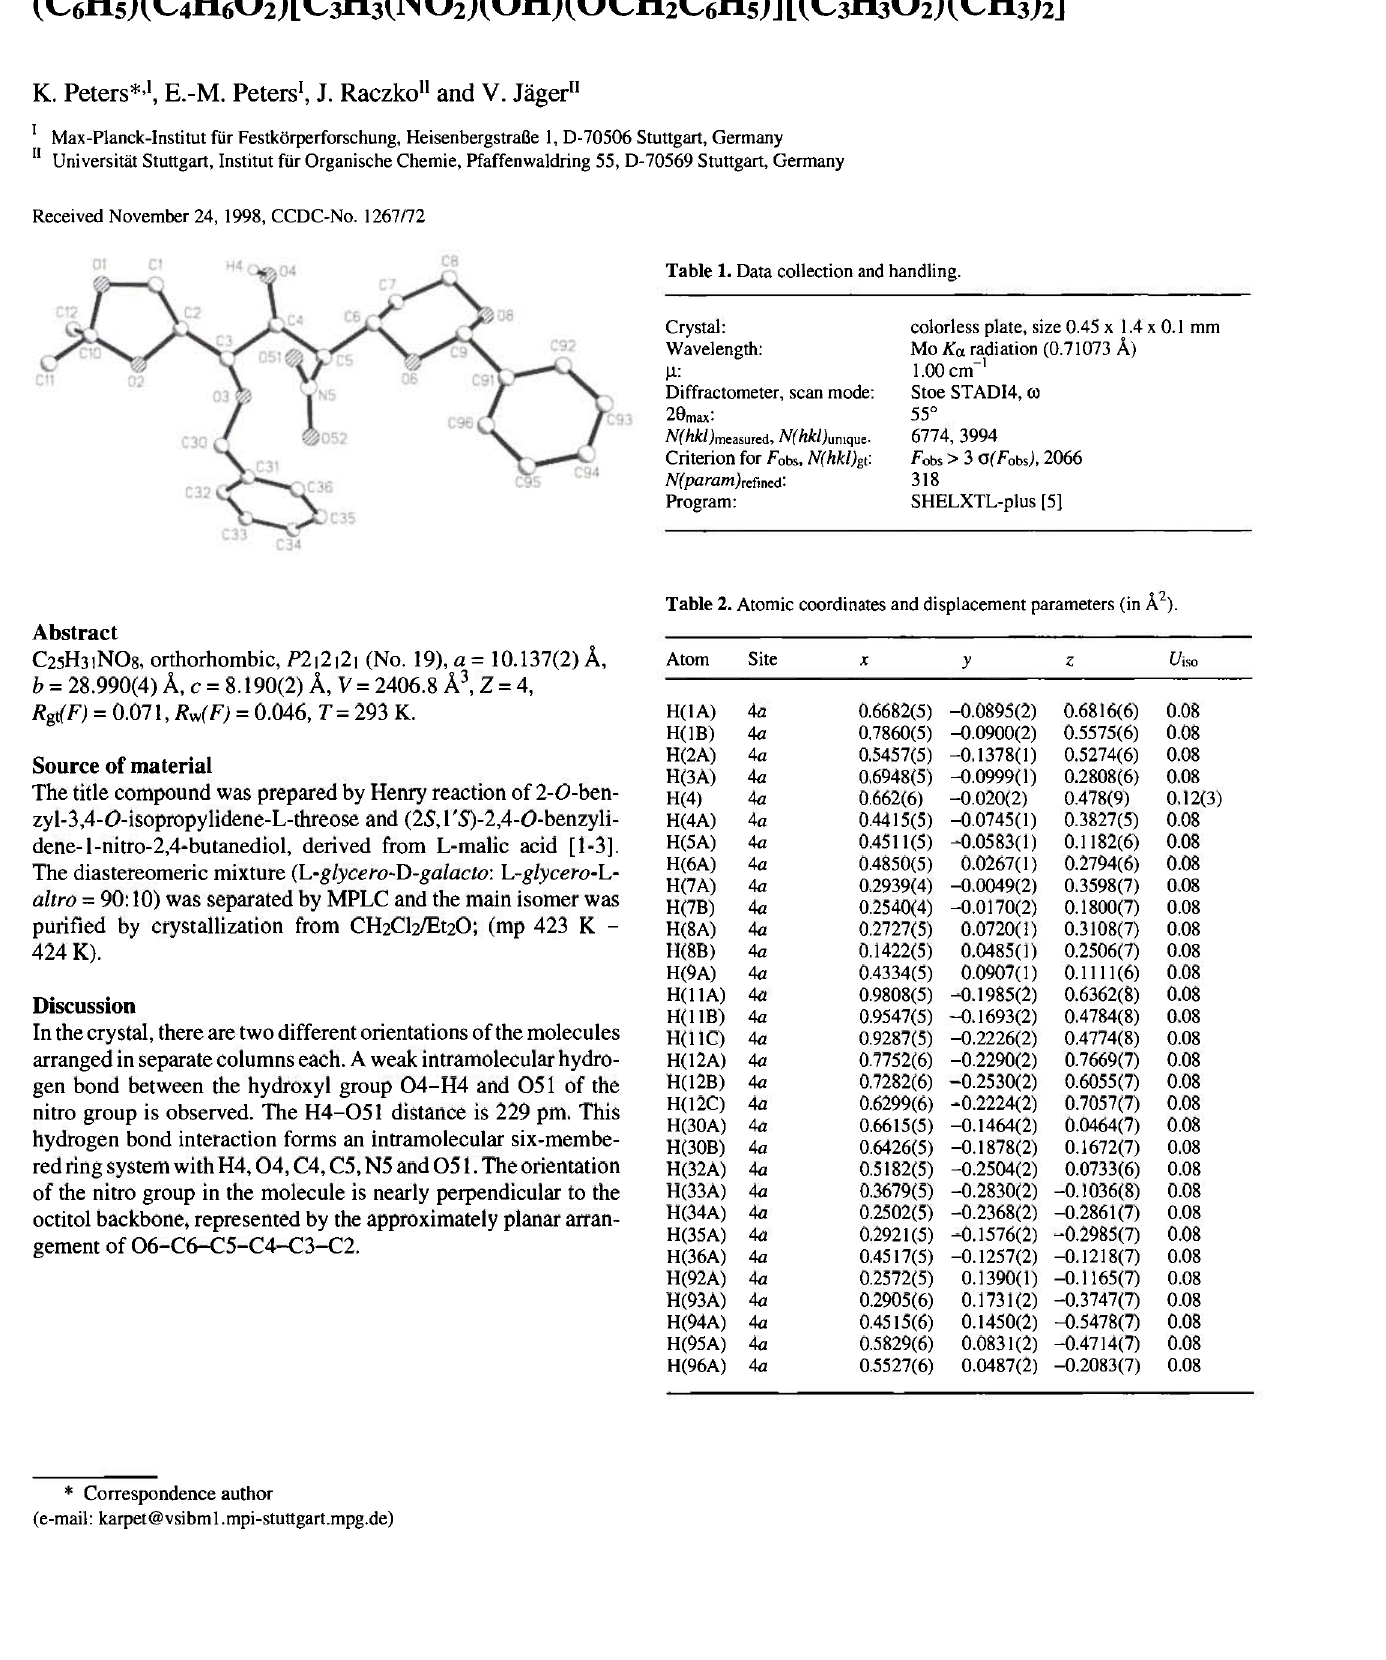
Table 1. Data collection and handling.